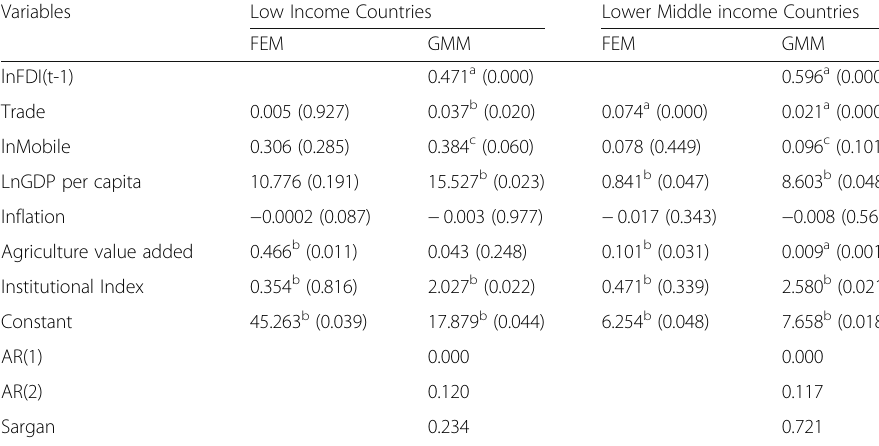
Table 1 Estimation Results for Developing Countries Variables Low Income